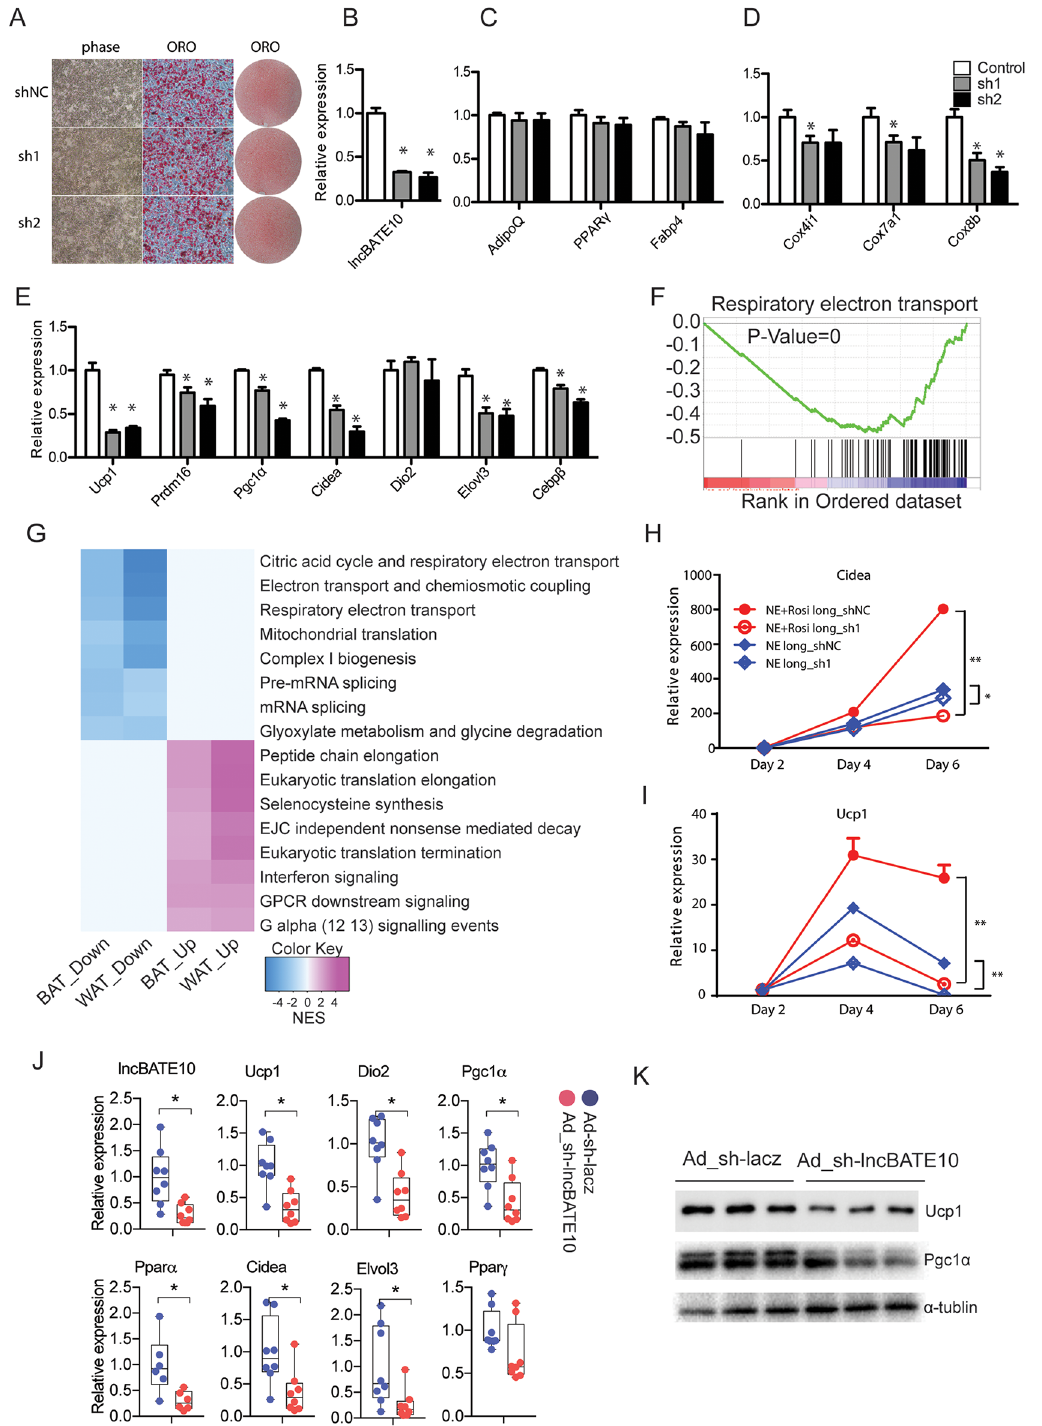
Fig 4. Brown adipose tissue–enriched lncRNA 10 (lncBATE10) is required for a brown adipose tissue (BAT)- selectivegene program in the browning of white fat. (A) The effect of lncBATE10 knockdown on lipid accumulation in primary white adipocyteculture was examinedby Oil-Red-O (ORO) staining. (B) The knockdown efficiency, (C) pan- adipogenicmarkers, (D) mitochondria genes, and (E) BAT-selective genes were examinedby real-time PCR. Error bars represent mean ± SEM, n = 3. * P < 0.05 (1-way ANOVA). (F) Gene-set enrichment analysis(GSEA) analysiswas performed on RNA-seq data from control and lncBATE10 knockdown white adiposetissue (WAT) samples.